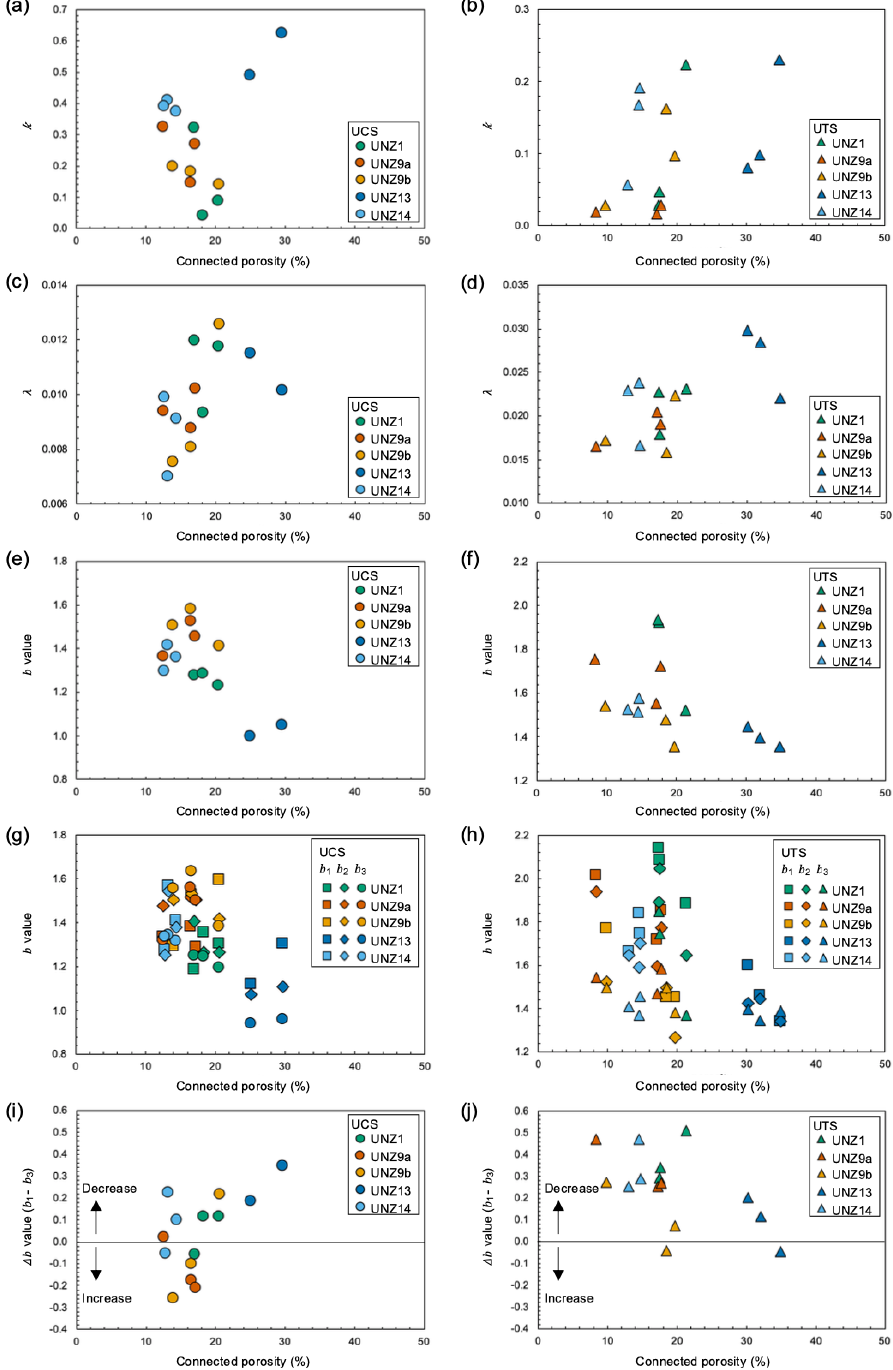
Figure 7. Acoustic emission analysis data for all dry tests in compression and tension (see Fig. S5 for the dataset). The parameter k (which relates to the absolute amplitude of acceleration) is shown as function of connected porosity for (a) UCS with no systematic relationship and (b) UTS with a weak positive correlation. The exponential rate parameter λ is plotted as a function of connected porosity for (c) UCS and (d) UTS, both showing a weak positive correlation. A negative correlation is seen between the b value and connected porosity for (e) UCS and (f) UTS. The AE data were split into thirds to examine b value evolution across first ( b 1 ), second ( b 2 ), and third ( b 3 ) segments of deformation as a function of connected porosity, shown for (g) UCS tests and (h) UTS tests. This evolution is quantified by (cid:49)b ( b 1 − b 3 ), where positive values indicate reduction in b value throughout a test: (i) in UCS (cid:49)b increases as a function of increasing porosity and spans from negative to positive values; (j) in UTS (cid:49)b decreases as a function of increasing porosity and is almost always positive.